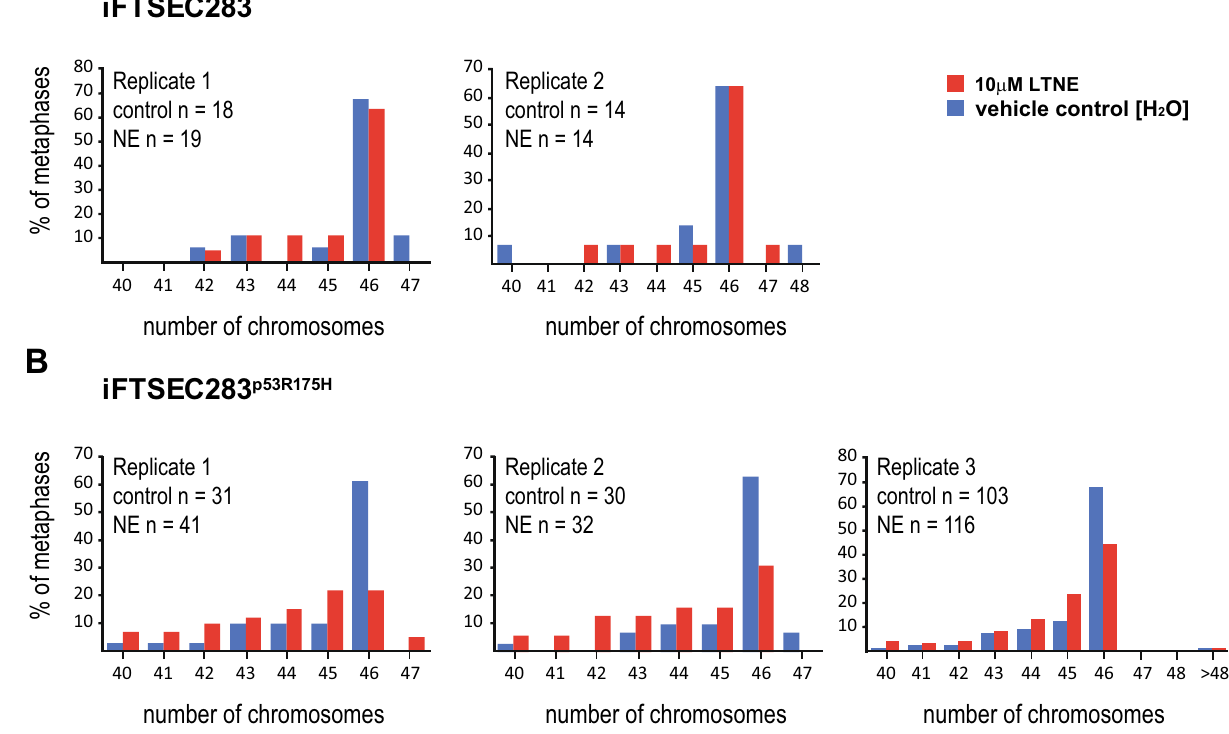
Figure 3. Effect of long-term exposure to NE on chromosome number. ( A ) Percentage of metaphase containing the indicated number of chromosomes in 10 µM NE (red bars) and mock-treated (blue bars) iFTSEC283 cells. ( B ) Percentage of metaphase containing the indicated number of chromosomes in 10 µM NE (red bars) and mock-treated (blue bars) iFTSEC283 p53R175H cells. Absolute number of metaphases assessed in each condition is also